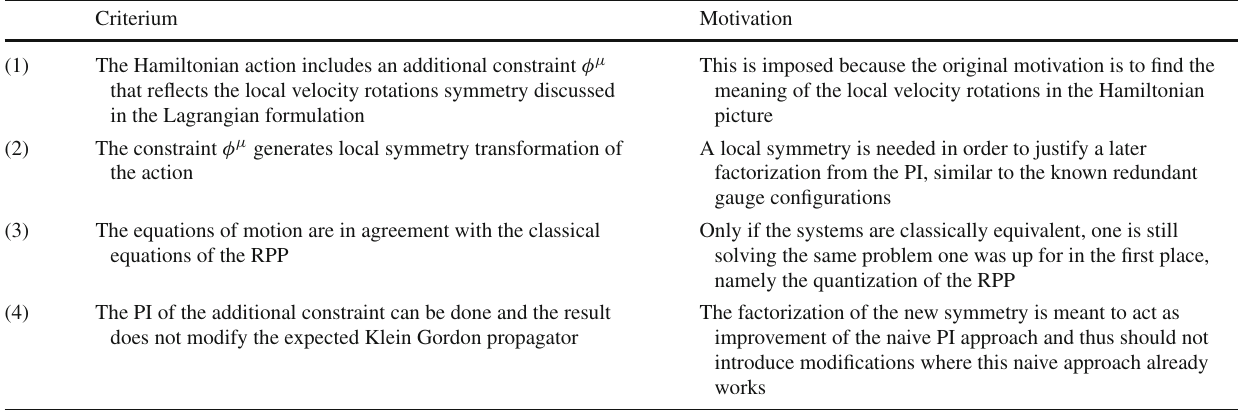
Table 1 Summary of different criteria and corresponding motivation for symmetry-related constraints in the Hamiltonian formulation Criterium Motivation